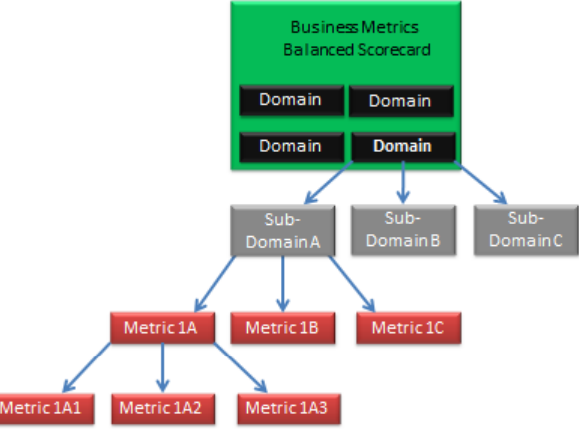
Figure 1. Domain metric break down.